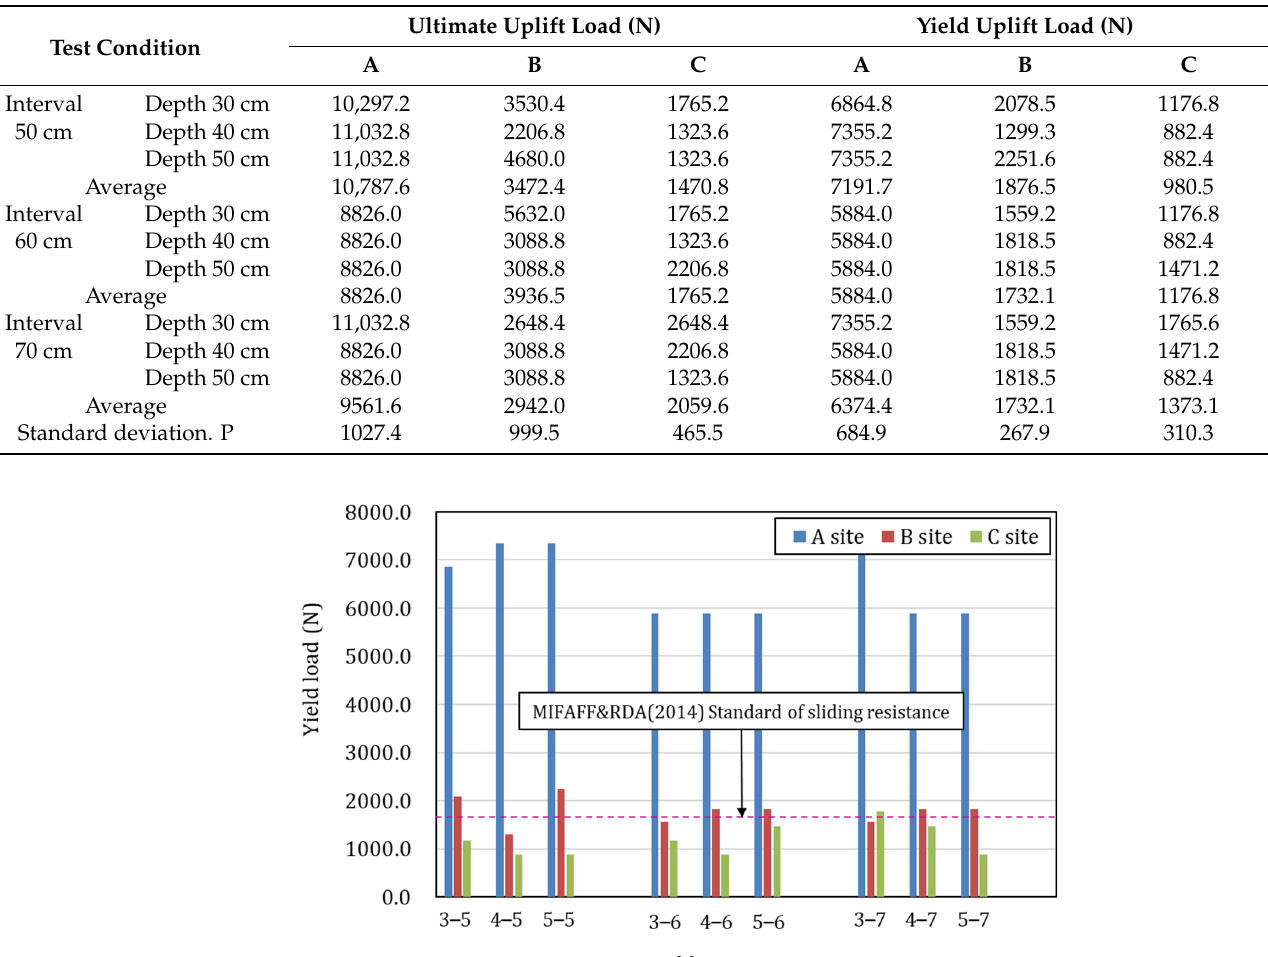
Table 6. Yield load of slipping to pipe connector on site A, site B, and site C.